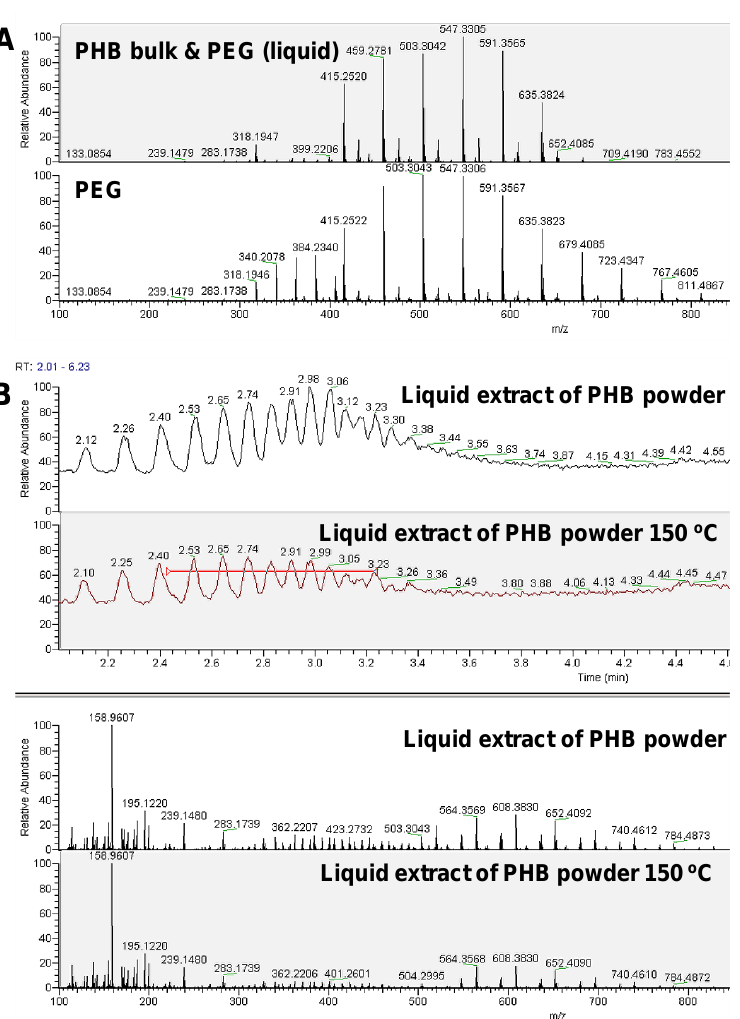
Figure 5. HPLC-MS analysis on hypothesis of degradation of PHB macromolecules. ( A ) Comparison between PEG and liquid part of mixture of PHB bulk and PEG after treatment under 150 ◦ C for 4 h. ( B ) Extract of PHB powder before and after treatment under 150 ◦ C for 4 h with solvent of methanol: dichloromethane = 1:1.